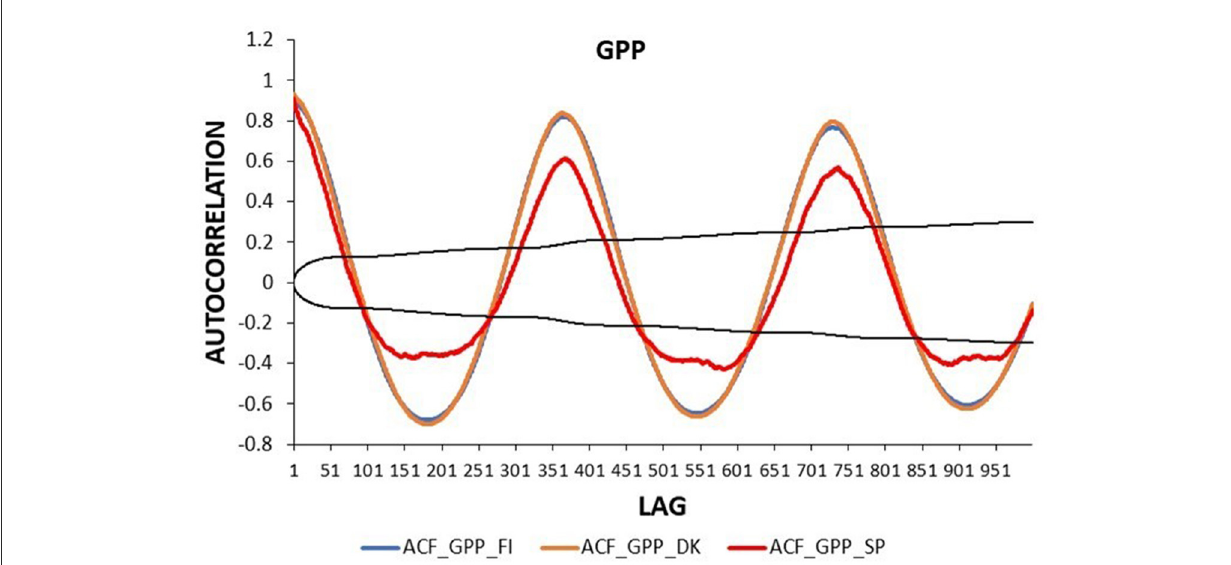
FIGURE4 Autocorrelation function of daily GPP time series in three European ecosystems: Evergreen Needleleaf Forest of Finland (ENF_FI, blue line), Deciduous Broadleaf Forest of Denmark (DBF_DK, orange line), and Mediterranean Savanna ecosystem of Spain (SAV_SP, red line). The black lines represent the interval of confidence in the autocorrelation